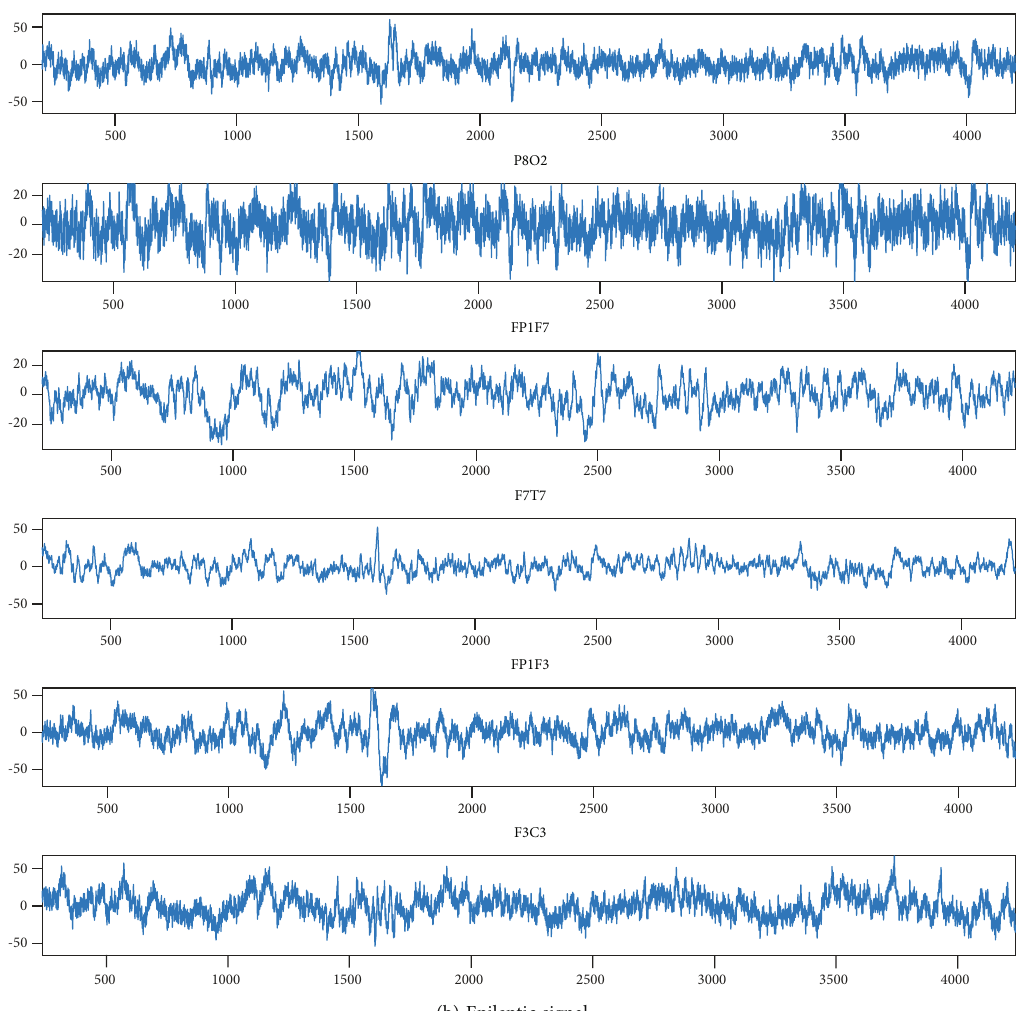
Figure 3: Similarity of signals from di ff erent